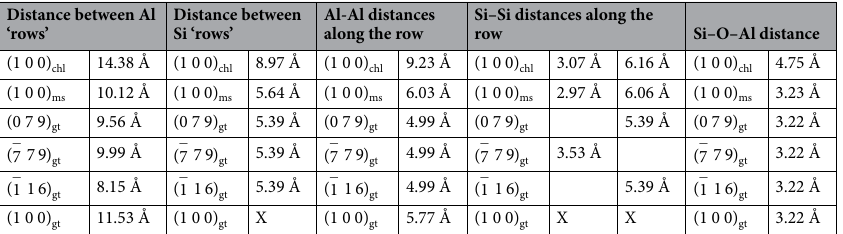
Table 1. Distances between and along Al and Si rows in chlorite, garnet, and muscovite. All measurements were made using VESTA 46 .